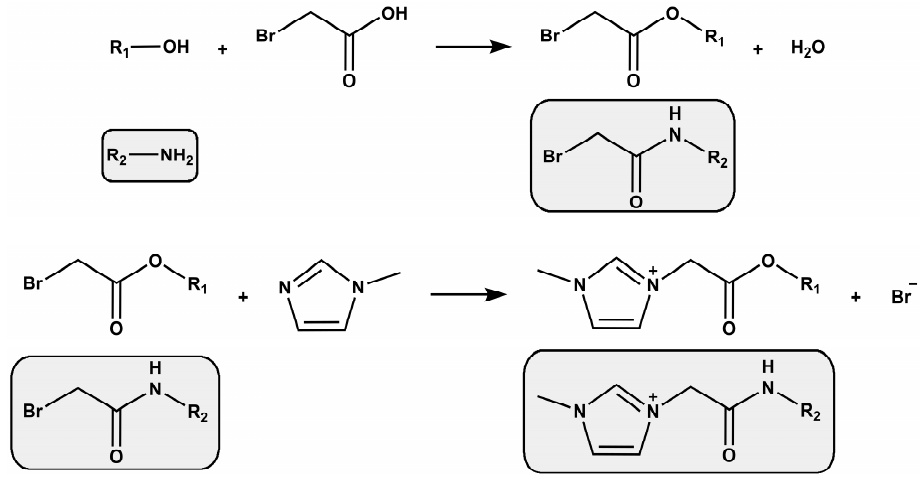
Scheme 1. Schematic representation of the synthesis of ionic liquids and ionic liquid-based surfactants. MW and US refer to microwave and ultrasound irradiation, respectively.